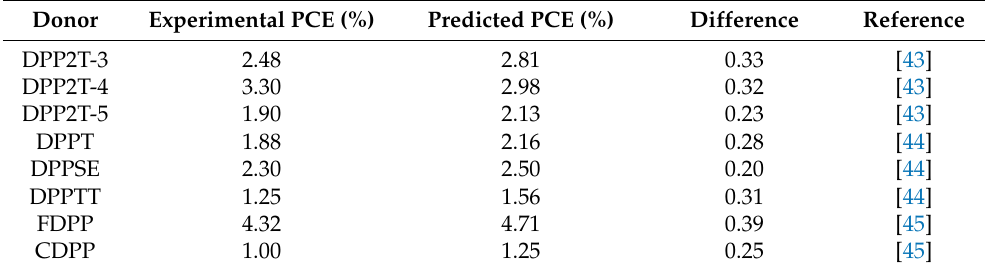
Table 3. Validation of random forest model using external